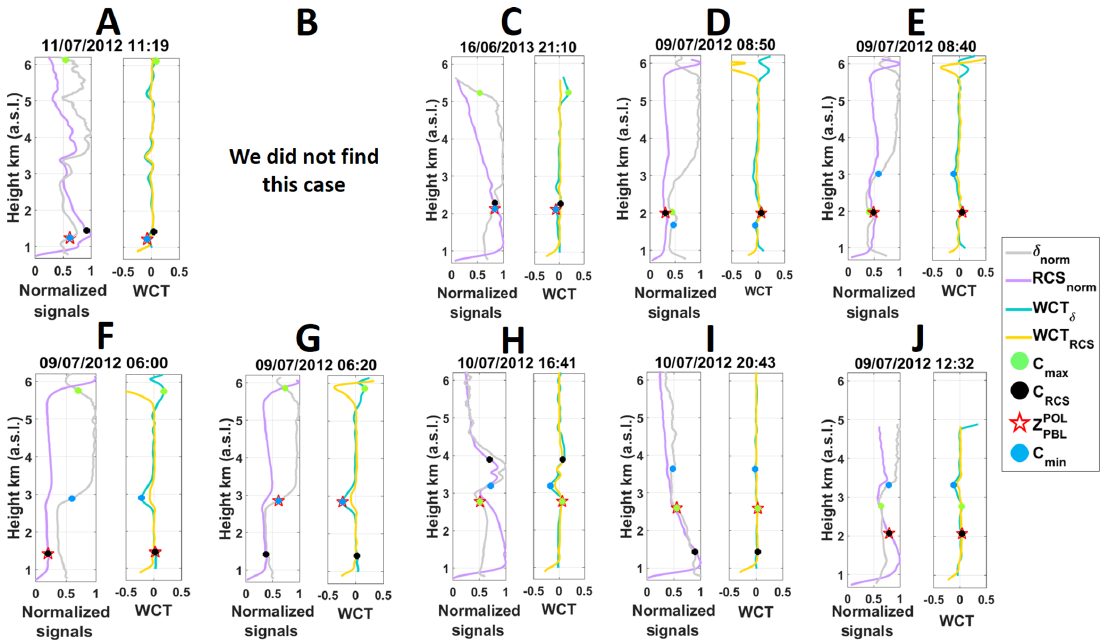
Figure 4. Examples of the cases mentioned in Fig. 3 occurred during ChArMEx 2012 and 2013. Normalized RCS (violet line) and δ (grey line) are shown on the left, and WCT of RCS (yellow line) and δ (light blue line) are shown on the right. C min (blue dot), C max (green dot), C RCS (black dot) and the final attribution z POL (red start) are shown in both PBL